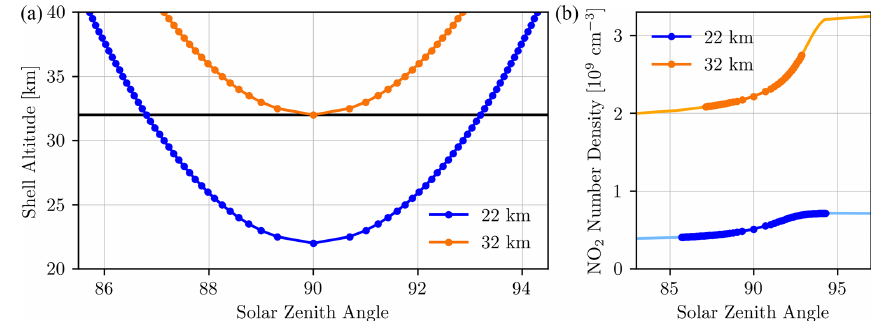
Figure 3. (a) Change in SZA with shell altitude along two lines of sight for a simulated sunset occultation. (b) Change in NO 2 at tangent altitudes of 22 and 32km for the same simulated sunset occultation. The dark, dotted lines correspond to the lines of sight from (a)